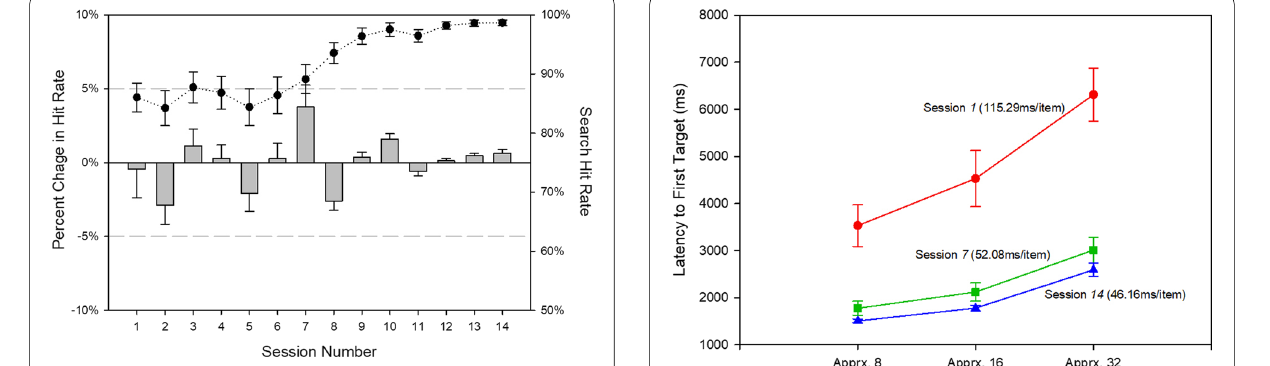
Fig. 3 Average search hit rates (circles) and percent change in hit rates (bars) across sessions. Note that the percent change data are Fig. 4 Average raw latency to the first target detection across scaled relative to each participants’ grand average, but the raw values effective set sizes 8, 16, and 32 for sessions 1, 7, and 14. Error bars reflect group averages. Error bars reflect 1 standard error reflect 1 standard ± ± figures: The left axis reflects percent change and the right axis reflects raw data. For all analyses, alpha level was set at 0.05, and multiple comparisons were subjected to Bonferroni corrections. Greenhouse–Geisser-corrected degrees of freedom are reported for any contrasts involv- ing sphericity violations.